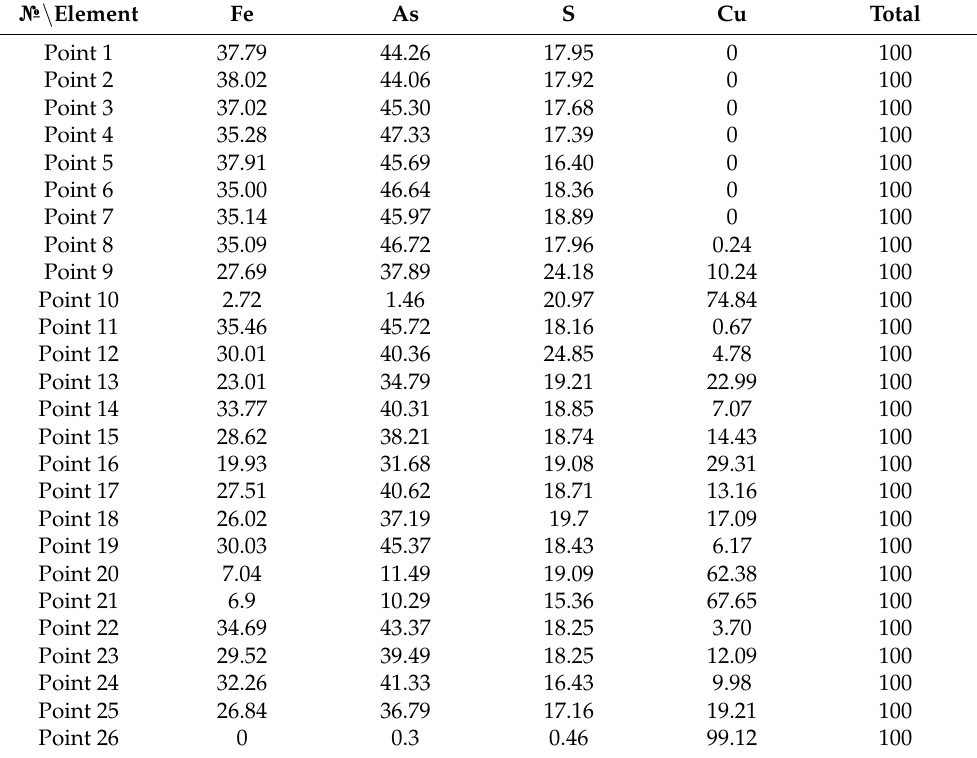
Table 3. Normalized EDS analysis results